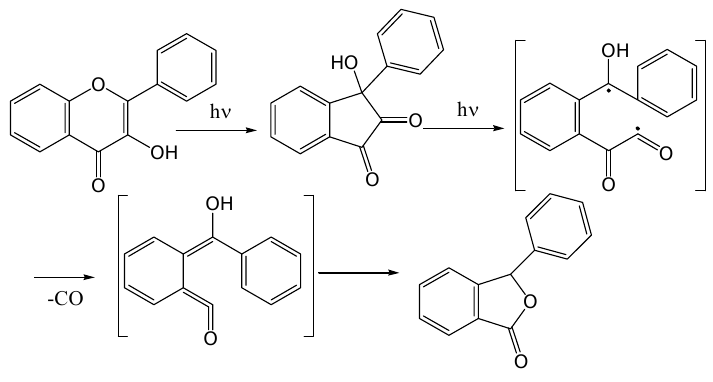
Scheme 15. Mechanism of Norrish type I formation of